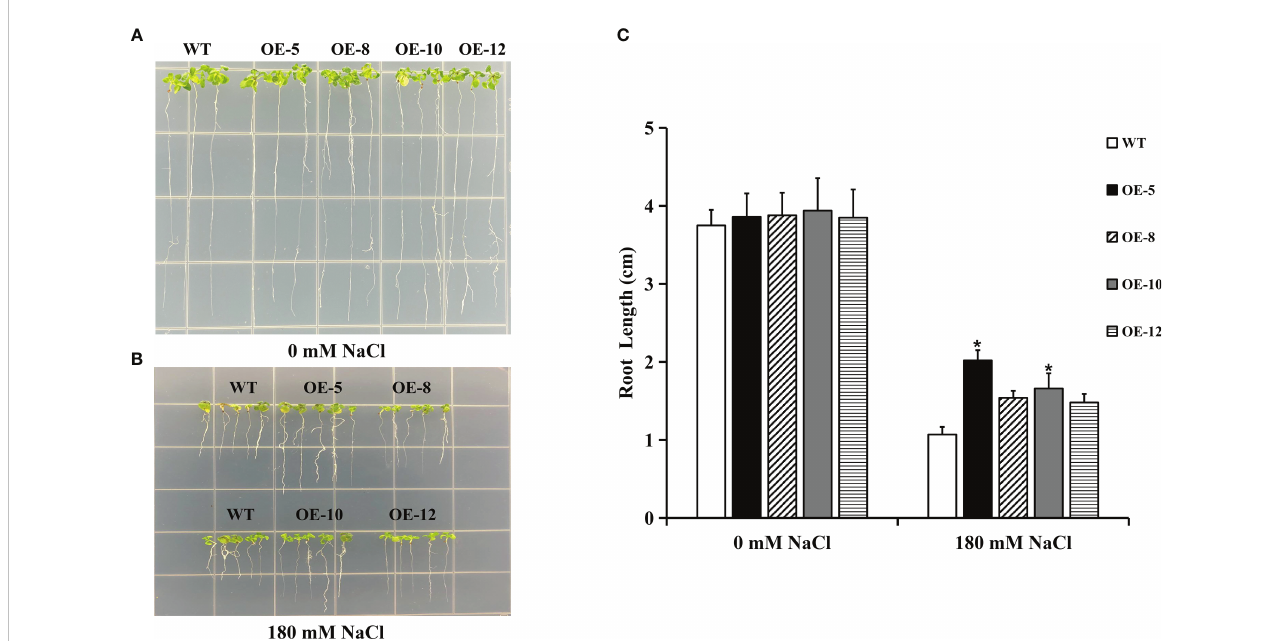
FIGURE 8 Transgenic plants overexpressing IpNAC5/8/10/12 had improved root length under salt stress. (A-C) Comparisons of the root length between wild type (WT) and transgenic Arabidopsis thaliana plants grown on 1/2 MS + 180 mM NaCl for 10 d. Data are the means ± SE of three independent biological experiments. OE-5 is an IpNAC5 -overexpressing plant, OE-8 is an IpNAC8 -overexpressing plant, OE-10 is an IpNAC10 -overexpressing plant, and OE-12 is an IpNAC12 -overexpressing plant. The p-values were evaluated using Student ’ s t -test. Asterisks indicate the level of signi fi cance, The meaning of the symbol “ * ” is the level of signi fi cance, * 0.01 < p < 0.05 , between the WT and transgenic plants.